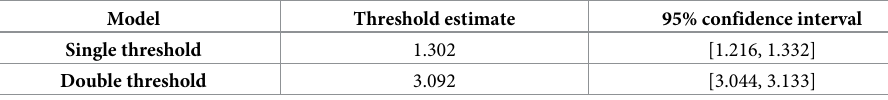
Table 4. Threshold estimates and confidence